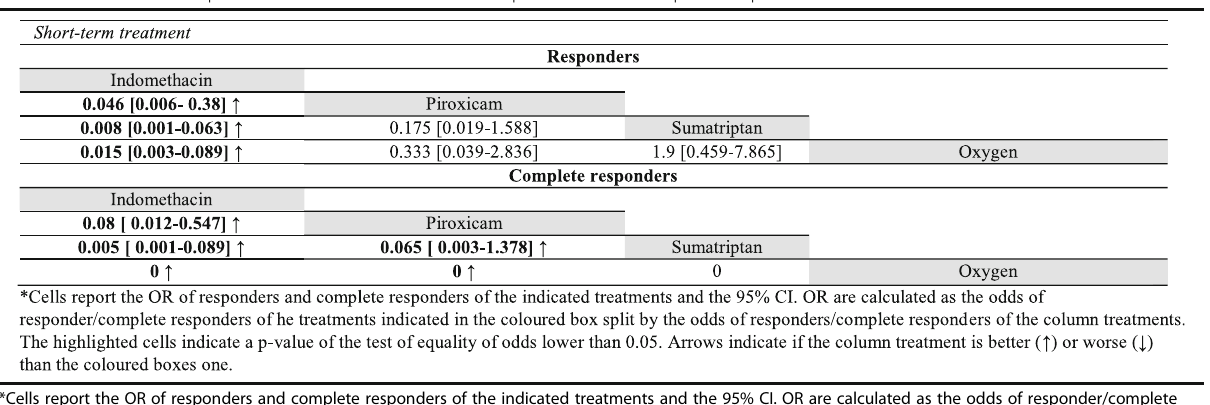
*Cells report the OR of responders and complete responders of the indicated treatments and the 95% CI. OR are calculated as the odds of responder/complete responders of he treatments indicated in the coloured box split by the odds of responders/complete responders of the column treatments. The highlighted cells